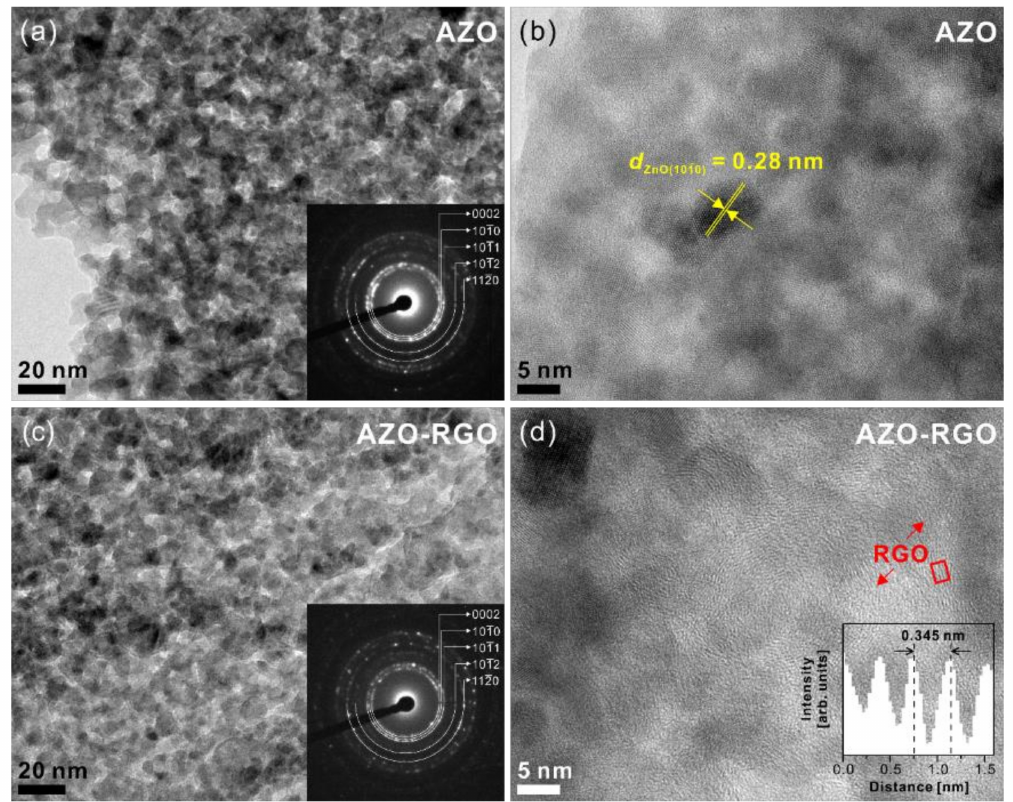
Figure 4. ( a ) Bright-field and ( b ) high-resolution TEM micrographs of AZO TF. ( c ) Bright-field and ( d ) high-resolution TEM micrographs of AZO-RGO NCTF. Insets in ( a ) and ( c ) represent the selected area electron di ff raction patterns. Inset in ( d ) shows the intensity profile obtained from the red rectangular